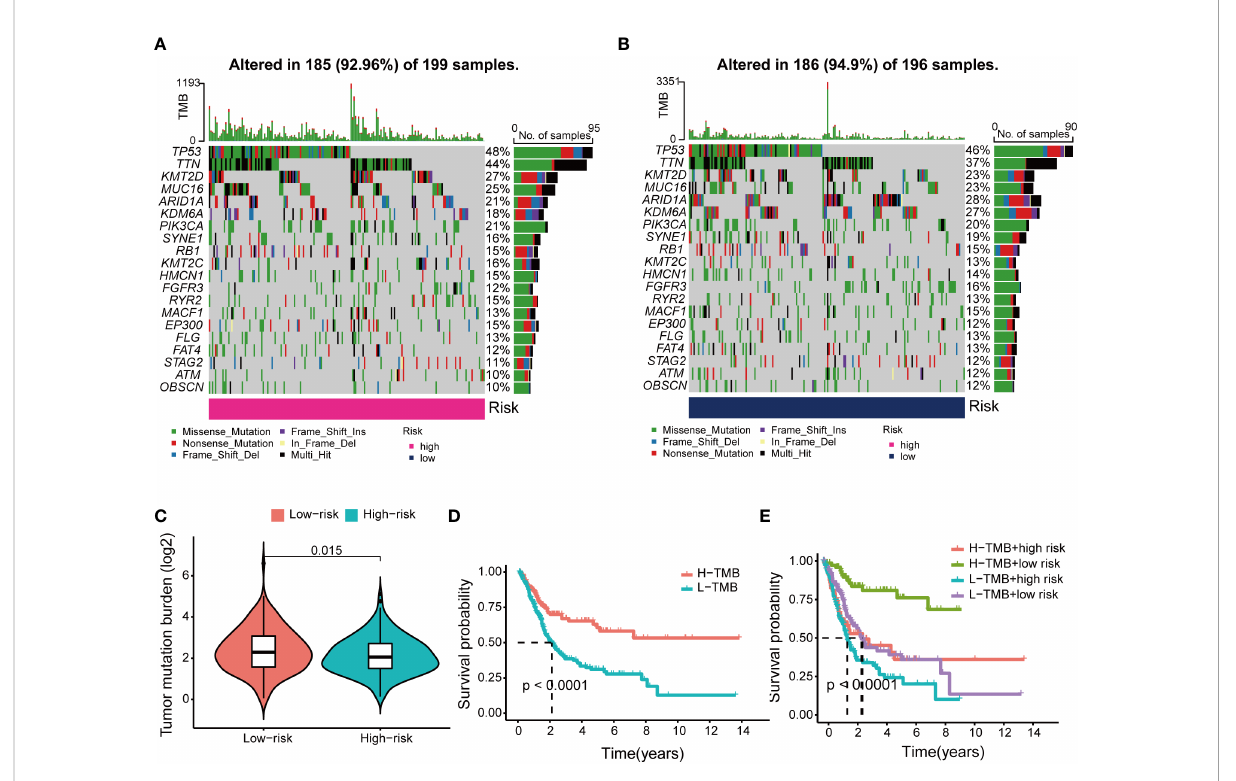
FIGURE 9 Differences and prognosis in tumor mutational burden (TMB). (A) The waterfall plot and heatmap of mutation genes in the high-risk group. (B) The waterfall plot and heatmap of mutation genes in the low-risk group. (C) Differences in TMB scores across risk groups. (D) Kaplan-Meier curves of H-TMB group and L-TMB group. (E) Kaplan-Meier curve of H-TMB and L-TMB scores in the different risk